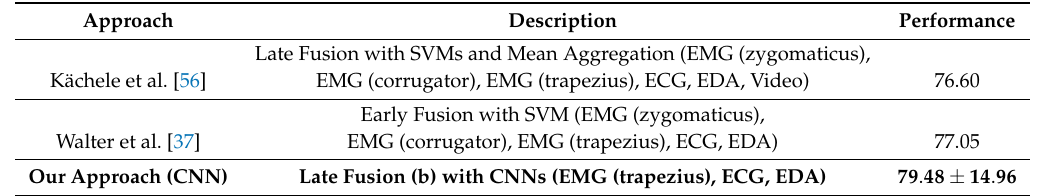
Table 8. Fusion performance comparison to early work on the BVDB (Part B) in a LOSO cross-validation setting for the classification task T 0 vs. T 4